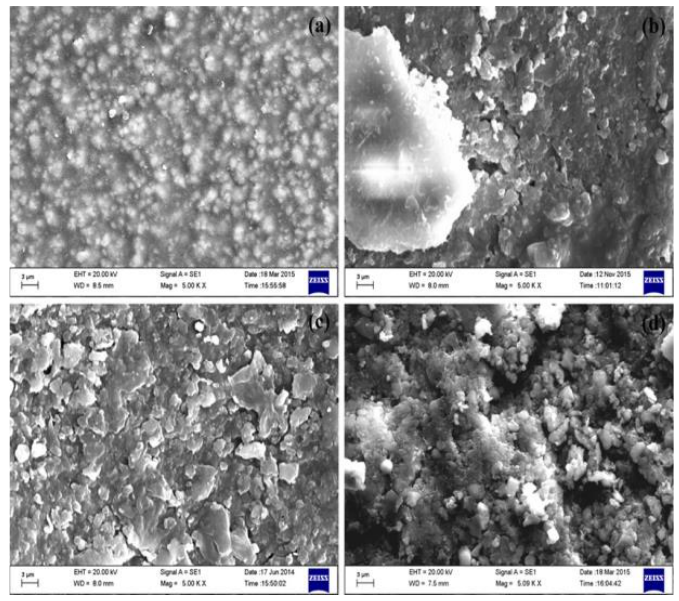
Figure 4. SEM images of the surface morphology changes of a ( a ) new (unaged) sample, ( b ) 3 years,